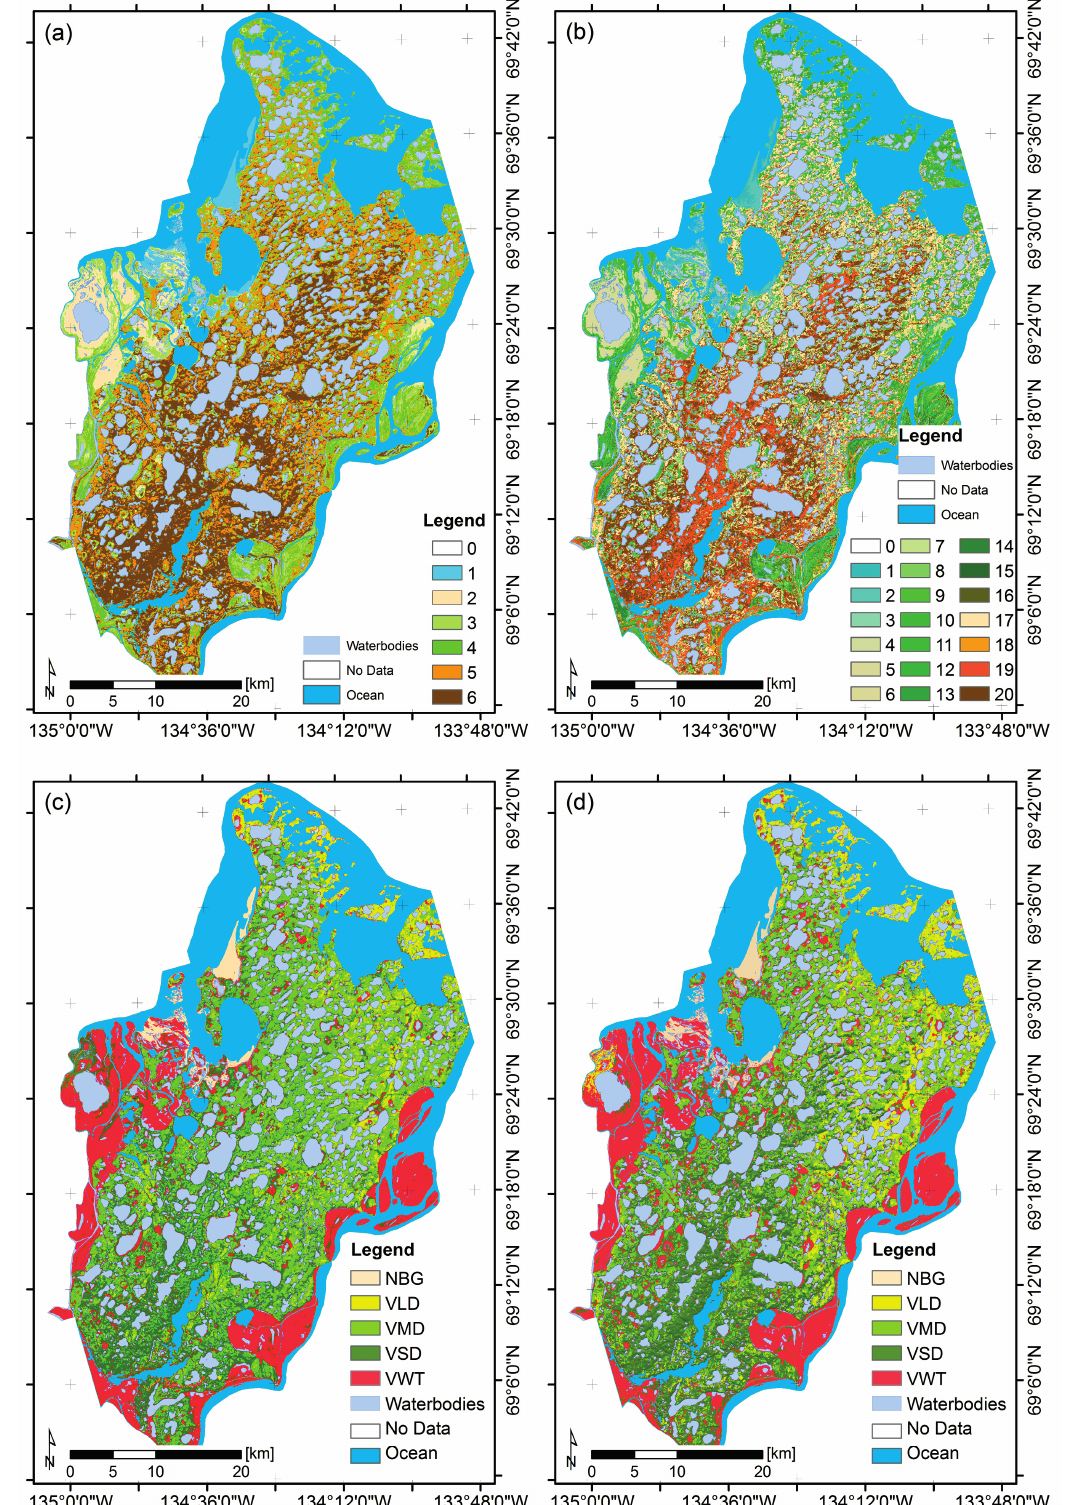
Figure 8. Results of unsupervised Jenks-Natural-Breaks classification of Landsat 8 Greenness ( a ); unsupervised Maximum-Likelihood classification of TerraSAR-X and Landsat 8 with 20 classes ( b ); unsupervised Maximum-Likelihood of TerraSAR-X and Landsat 8 with classes merged in accordance with in situ reference ( c ) and supervised classification result of Radarsat-2 and Landsat 8 ( d